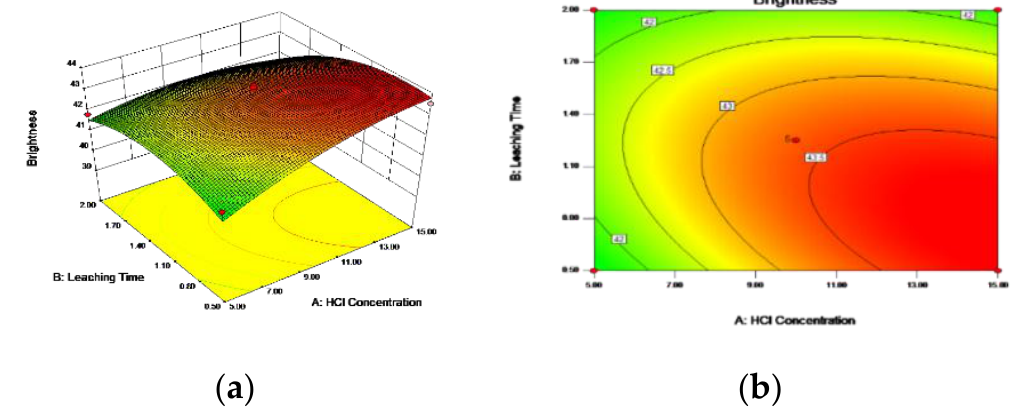
Figure 5. ( a ) The response surface plot and ( b ) the corresponding contour plot showing the effects of HCl Concentration and leaching Time on the brightness of fly ash by removing iron-containing oxides.